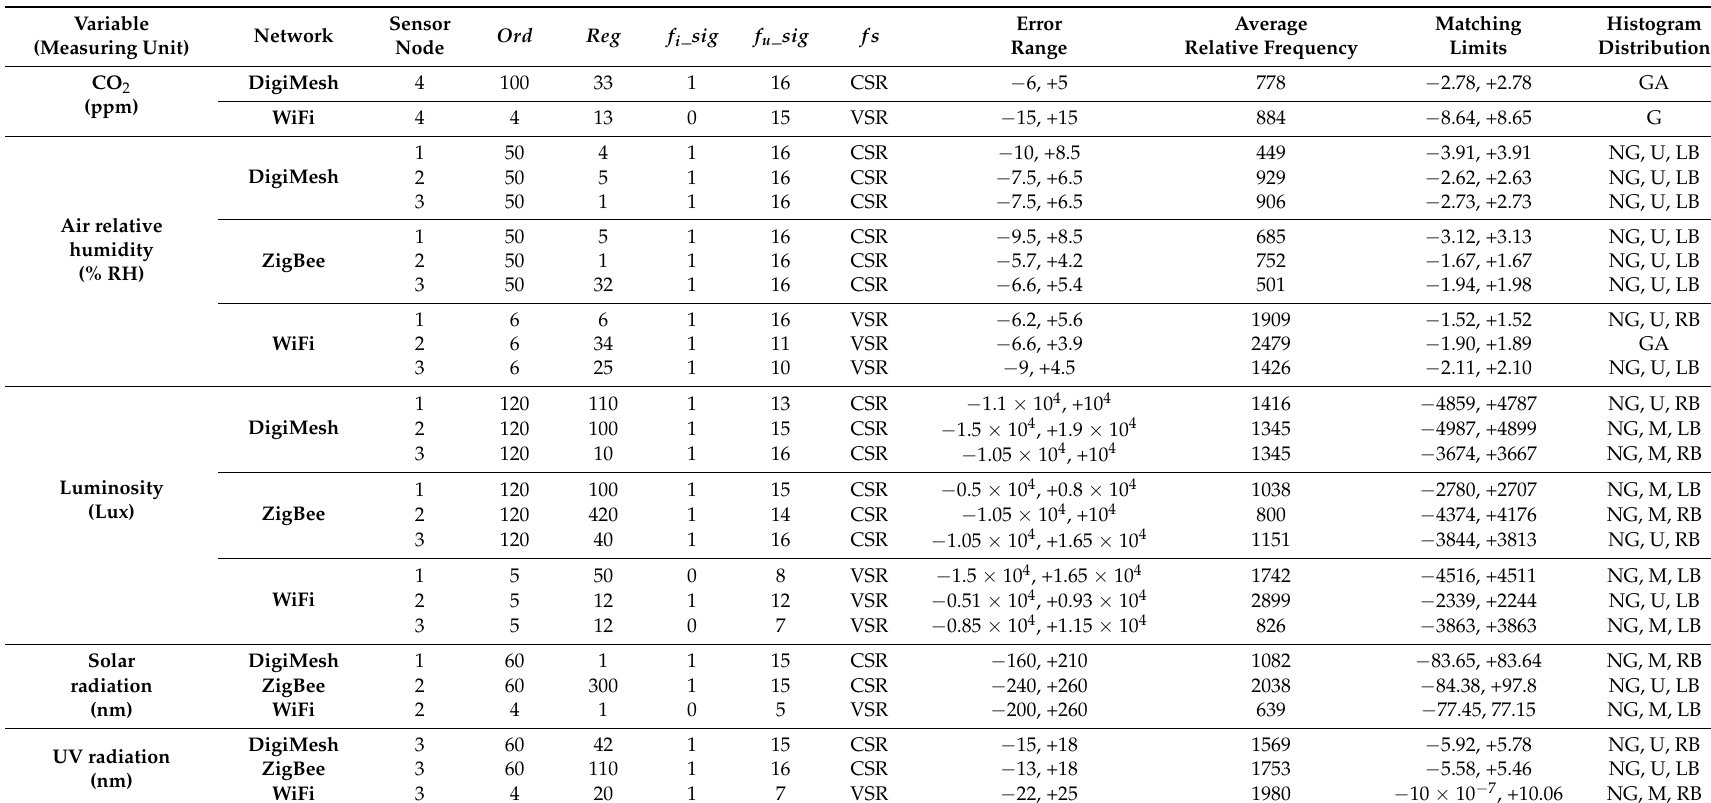
Table 2. Relevant parameters for model adjustment. For each network, node and sensor, the filtering order ( Ord ), the regularization parameter ( Reg ), and the number of significant infradian and ultradian components ( f i _ sig and f u _ sig ) are indicated. Error range, average relative frequency and mode of the residual histograms are indicated to summarize the residual analysis. The matching limits for the data and the model are also provided, as well as the qualitative description of the relevant features of the residual